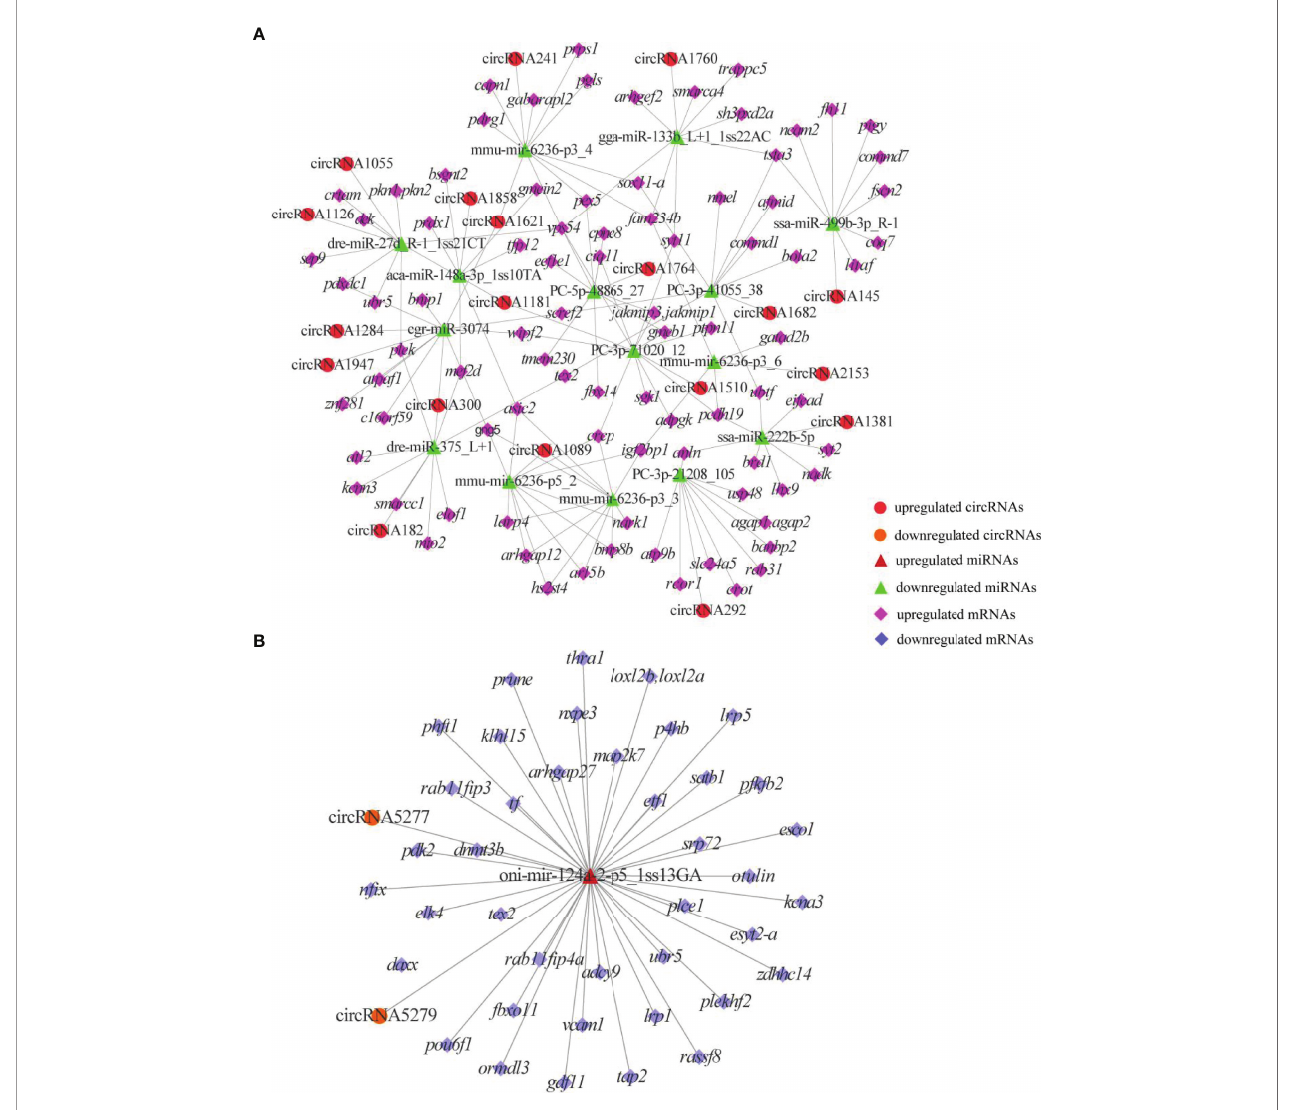
FIGURE 8 | DEcircRNAs-mediated ceRNA networks. (A) A ceRNA network of upregulated genes. (B) A ceRNA network of downregulated genes. The red circles, green triangles and pink diamonds represent upregulated DEcircRNAs, downregulated DEmiRNAs and upregulated DEmRNAs, respectively. The yellow circles, wine red triangles and blue diamonds represent downregulated DEcircRNAs, upregulated DEmiRNAs and downregulated DEmRNAs,